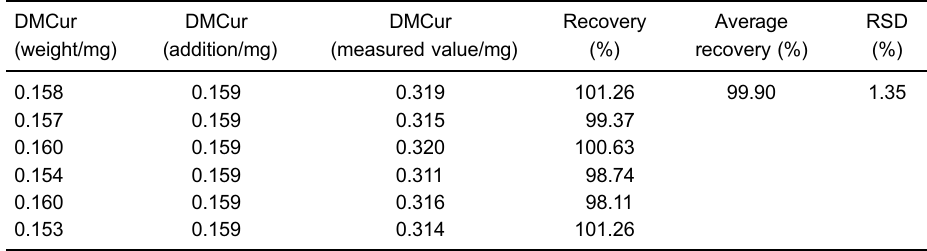
Table 3. Demethoxycurcumin (DMCur) sample recovery rate test results.